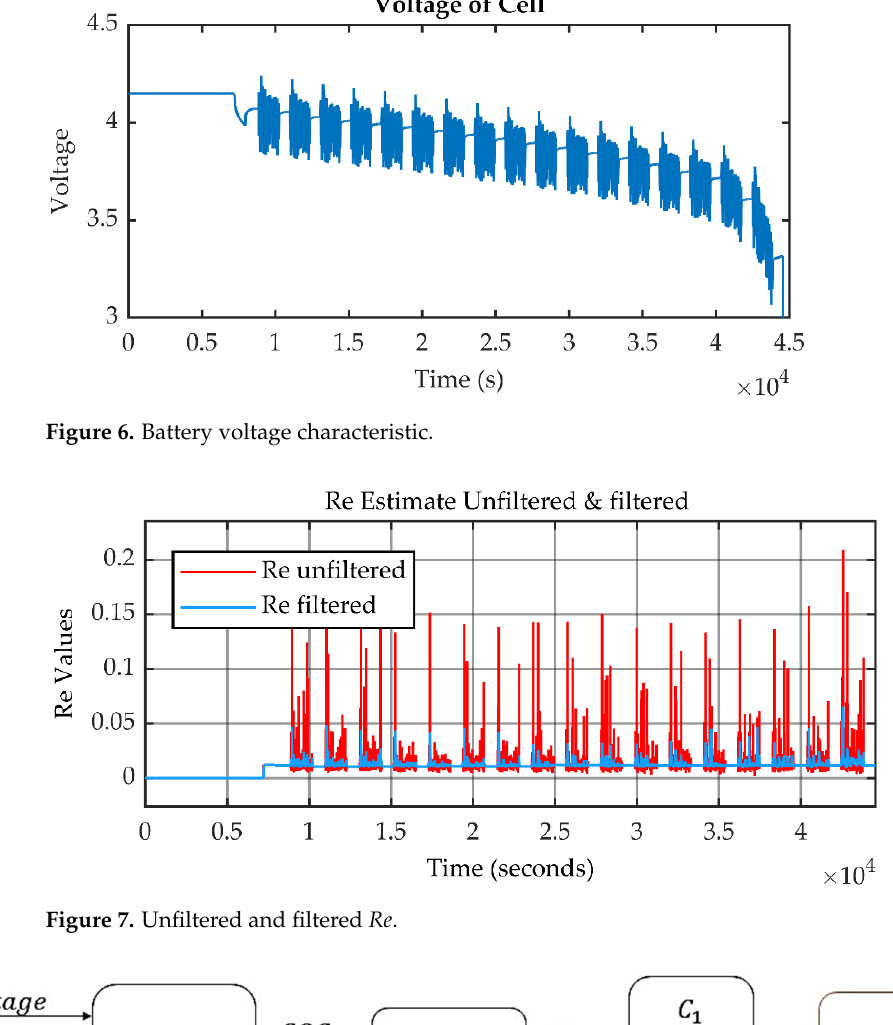
Figure 5. Battery current characteristic.